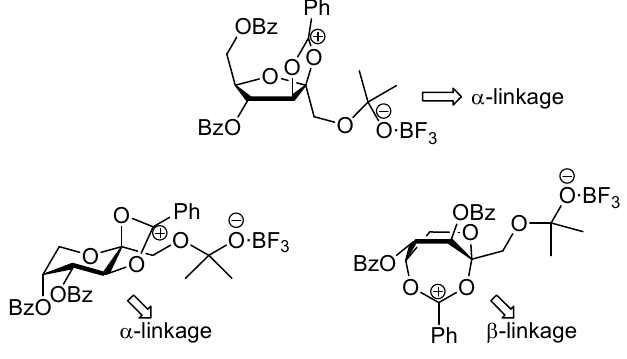
Figure 8 . Probable structures of the acyloxonium cations involved in the dimerization reaction of acylated D -fructose